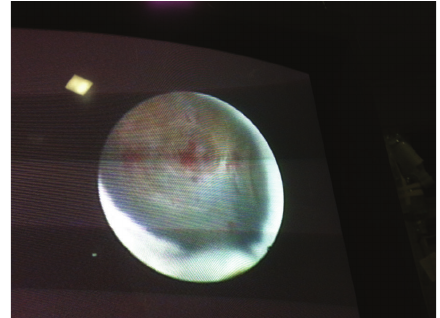
Figure 4: Seminal